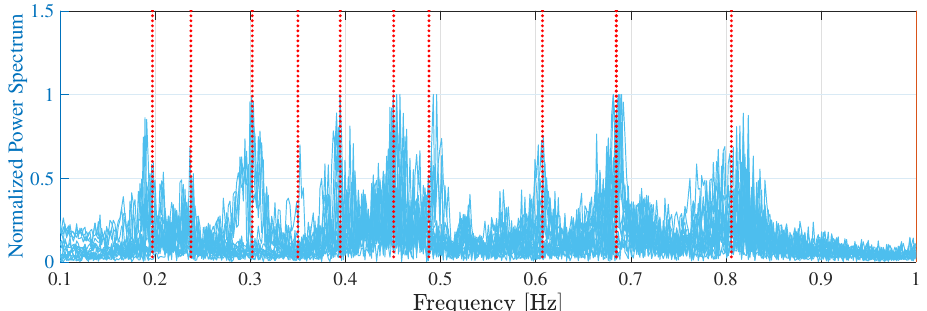
Figure 14. Normalized power spectrum and structural modes were identified using the semi- automated DD-SSI